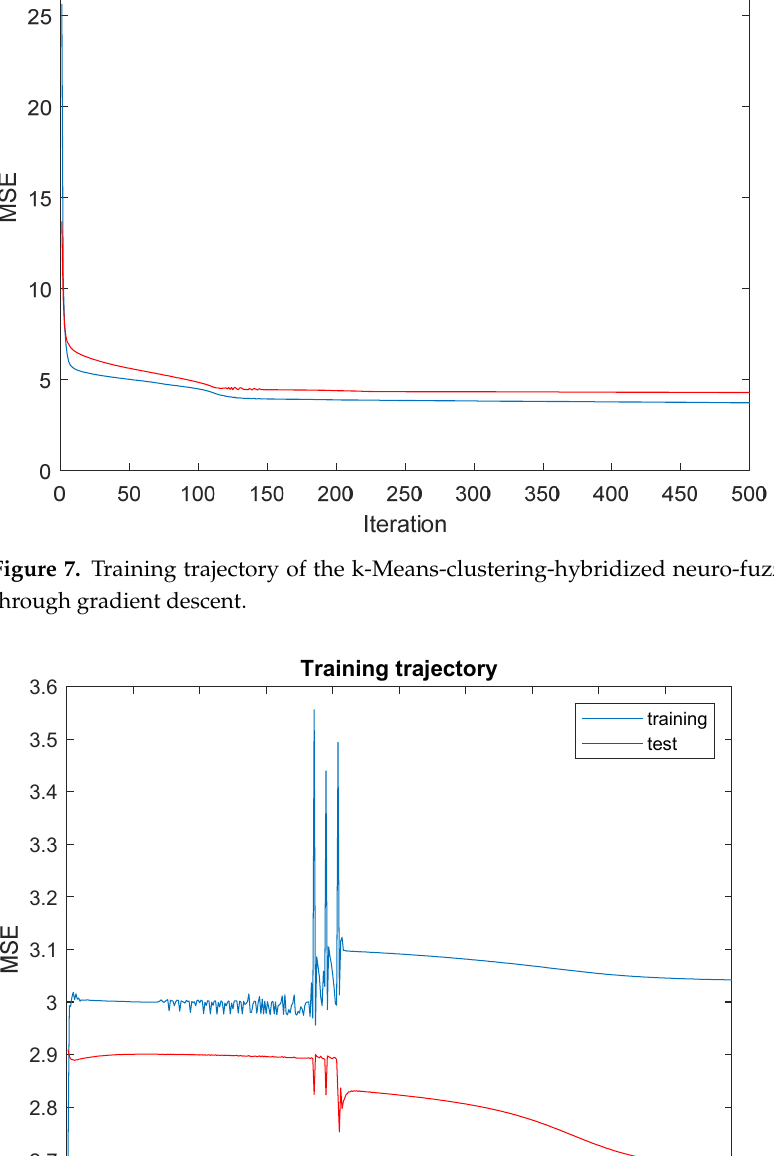
Figure 6. Evolution trajectory obtained by the GA specified, executed, and accelerated for the opti- mization of the k-Means-clustering-hybridized neuro-fuzzy classifier in this experiment. The GA was configured in terms of (population size, crossover fraction, mutation rate) at (350, 0.75, 0.01). The GA determined the fitness value, MSE, where the lower the error, the higher the fitness.